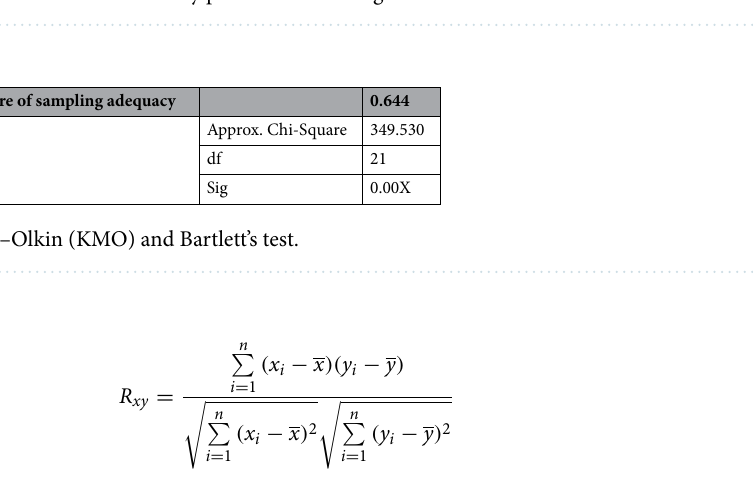
Table 3. Topographic parameters. Revised by parameters in Deng’s research 19 .